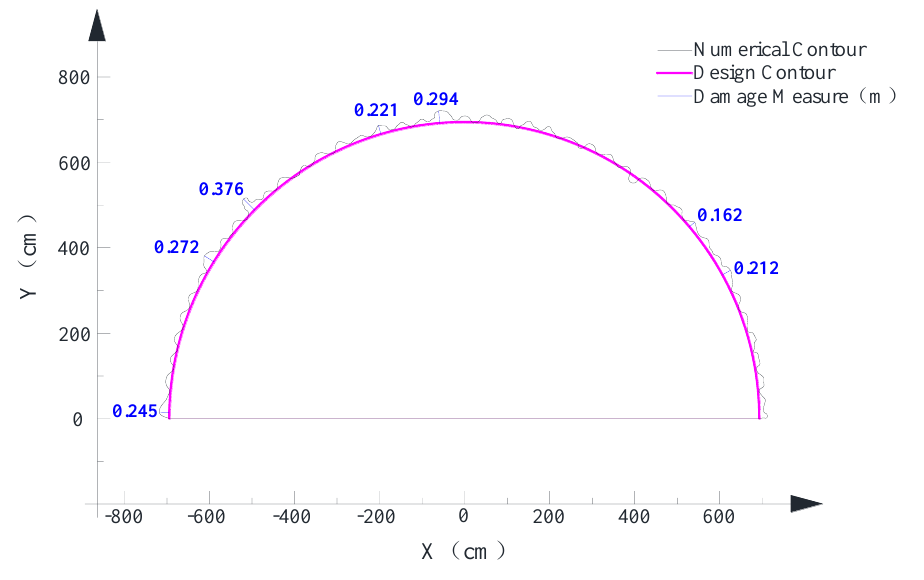
Figure 14. Damage contour in red obtained from the numerical study.